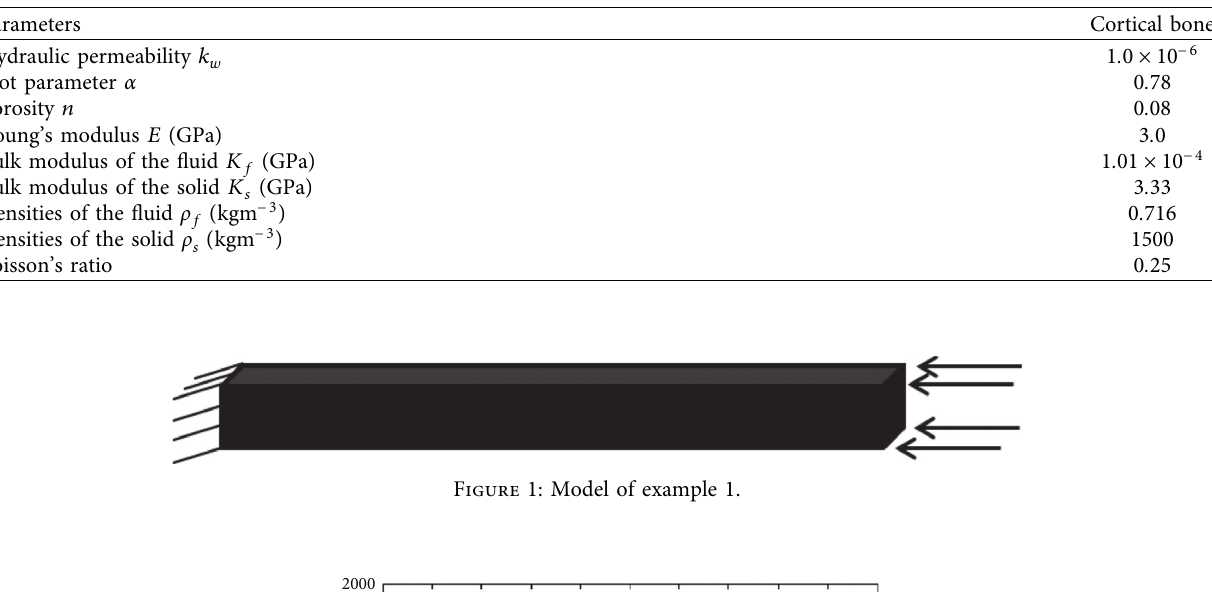
Table 1: Values of relevant parameters for calculations.